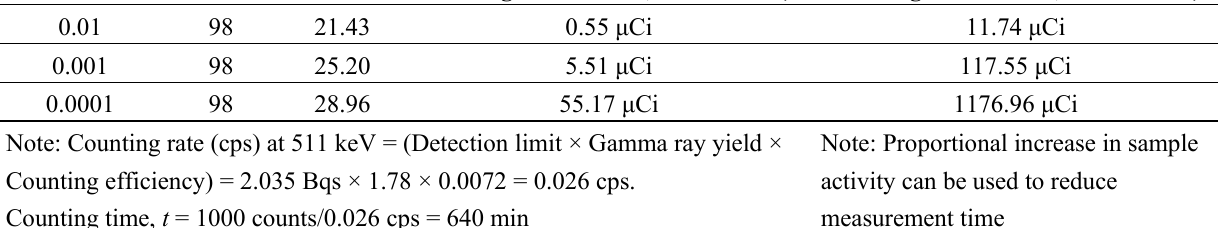
Table 4. 68 Ga product samples and relevant parameters of the designed protocol for gamma ray spectrum analysis of 68 Ge impure radionuclide. Gamma ray spectrum was measured with a dead time of 1%; Detection limits measured with a blank sample; Poisson distribution 95% confidence interval, 1.96 , C C ± with error < 8.77% for count numbers > 500. 68 68 68 (%) 100 ( / ( ) R Activity of Ge Activity of Ge Activity of Ga = × + . Activity of 68 Ga–sample taken out Activity of 68 Ga–sample taken out from 68 Ga–product solution at the product delivery time point (Measurement: 30 min counting for collecting 1000 counts; Error 6.2%) collecting 1000 counts; Error